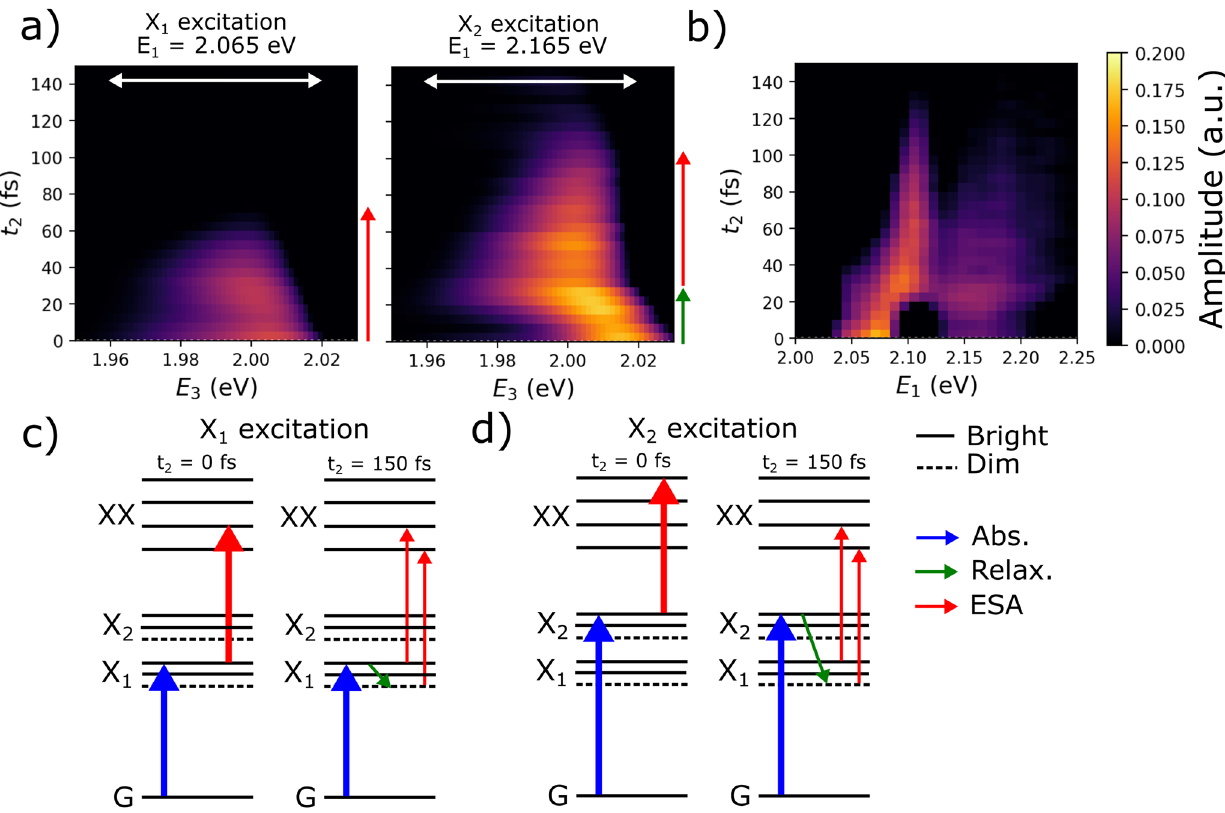
Fig. 4 Excited-state absorption (ESA) signals in CdSe quantum dots projected onto the emission and excitation axes. a Pseudo-TA spectra of CdSe QDs with X 1 and X 2 excitation. X 2 excitation results in an initial buildup followed by a decay. White arrows in panels a show the integration area for generating the plot in ( b ). b Projection of the ESA feature onto t 2 and the excitation energy E 1 shows that the ESA lifetime increases with excitation energy. The color bar corresponds to the amplitude of the ESA signal, truncating just the signal with positive amplitude. c Level diagrams show the intensity of the ESA transition re fl ects nonradiative relaxation within the manifold of X 1 states with X 1 excitation. d X 2 excitation results in successive relaxation from X 2 to X 1 and relaxation within the manifold of X 1